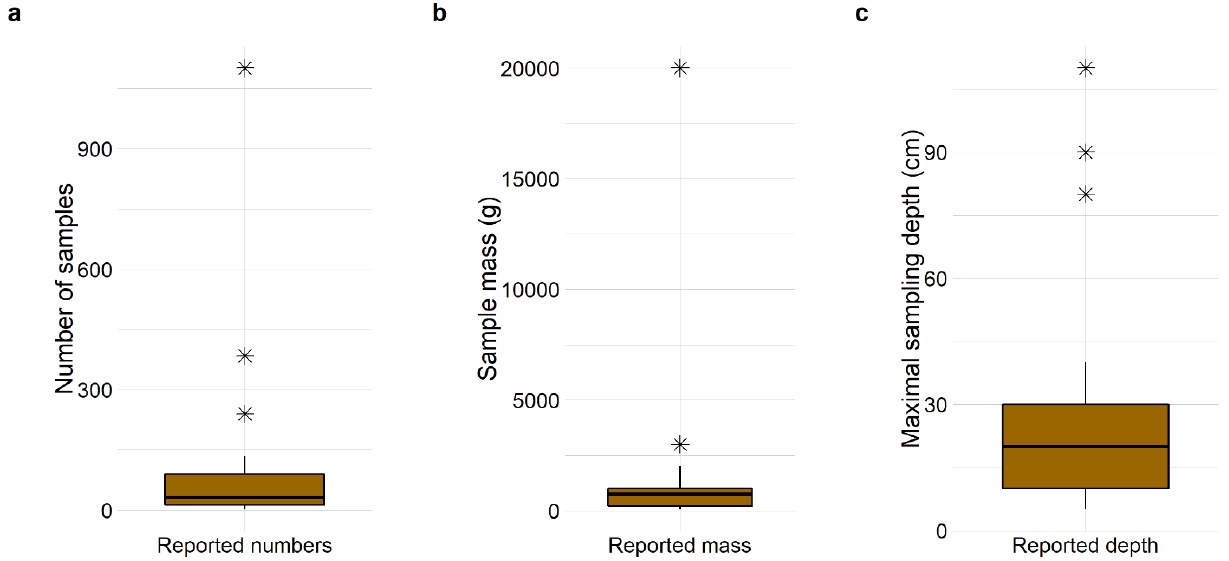
Figure 3. Documentation of sample numbers, sample mass and sampling depth within the evaluated (n = 35) publications: ( a ) Absolute number of samples reported (Table 1, 3-1). ( b ) Exact mass of samples (Table 1, 3-3) documented (data in volumes excluded). ( c ) Maximal depth of sampling (Table 1, 3-5) documented. Outliers displayed with star (*).